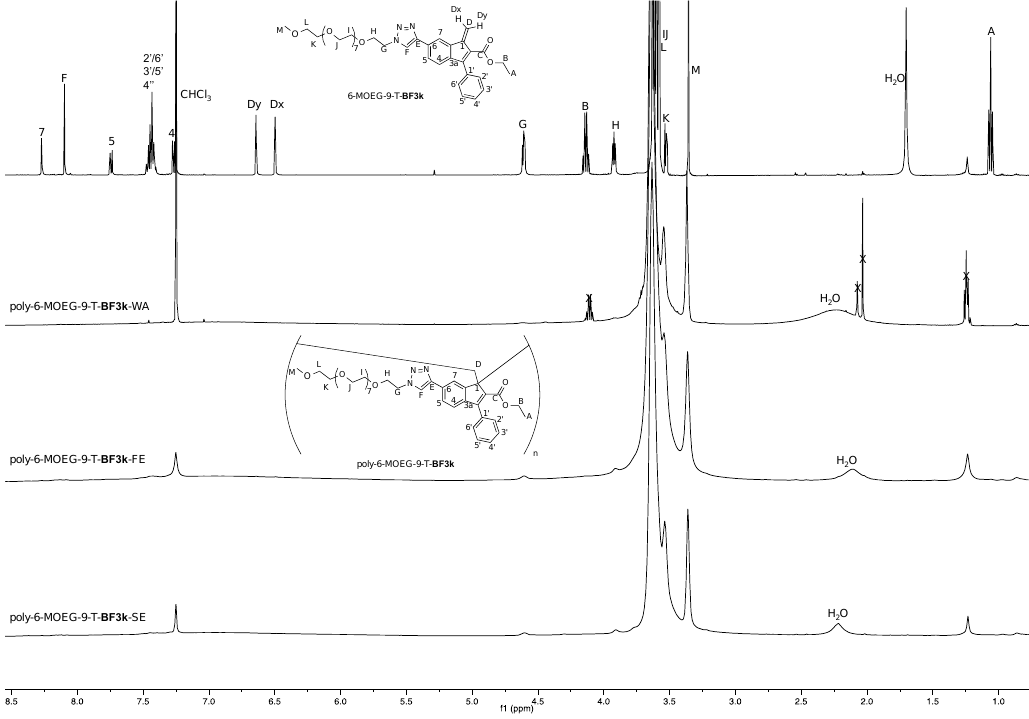
Figure 7. Comparison of the 1 H NMR spectrum of monomer 6-MOEG-9-T- BF3k (500 MHz, CDCl 3 , top trace) with those of the corresponding polymers: poly-6-MOEG-9-T- BF3k -WA, poly-6-MOEG-9-T- BF3k -FE, and poly-6-MOEG-9-T- BF3k -SE.